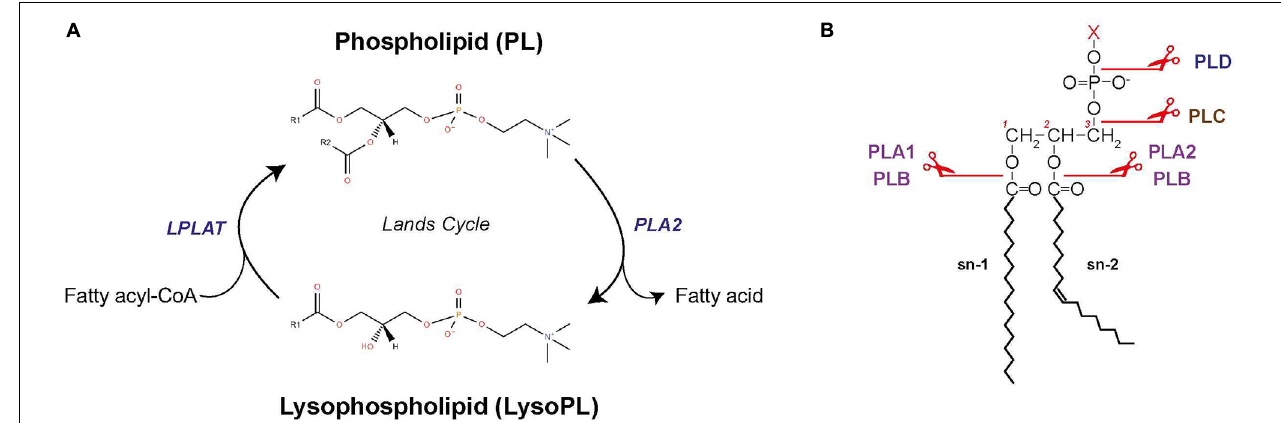
FIGURE 5 | Phospholipid remodeling. (A) Schematic of PL remodeling through the Lands cycle. (B) Sites of cleavage by the different phospholipases. LPLAT, lysophospholipid acyltransferase; PLA1, phospholipase A1; PLA2, phospholipase A2; PLB, phospholipase B; PLC, phospholipase C; PLD, phospholipase D.